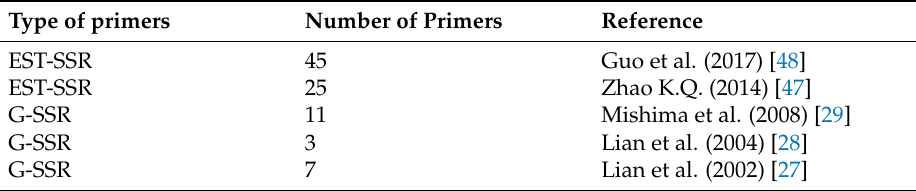
Table 6. Source of SSR primers in this